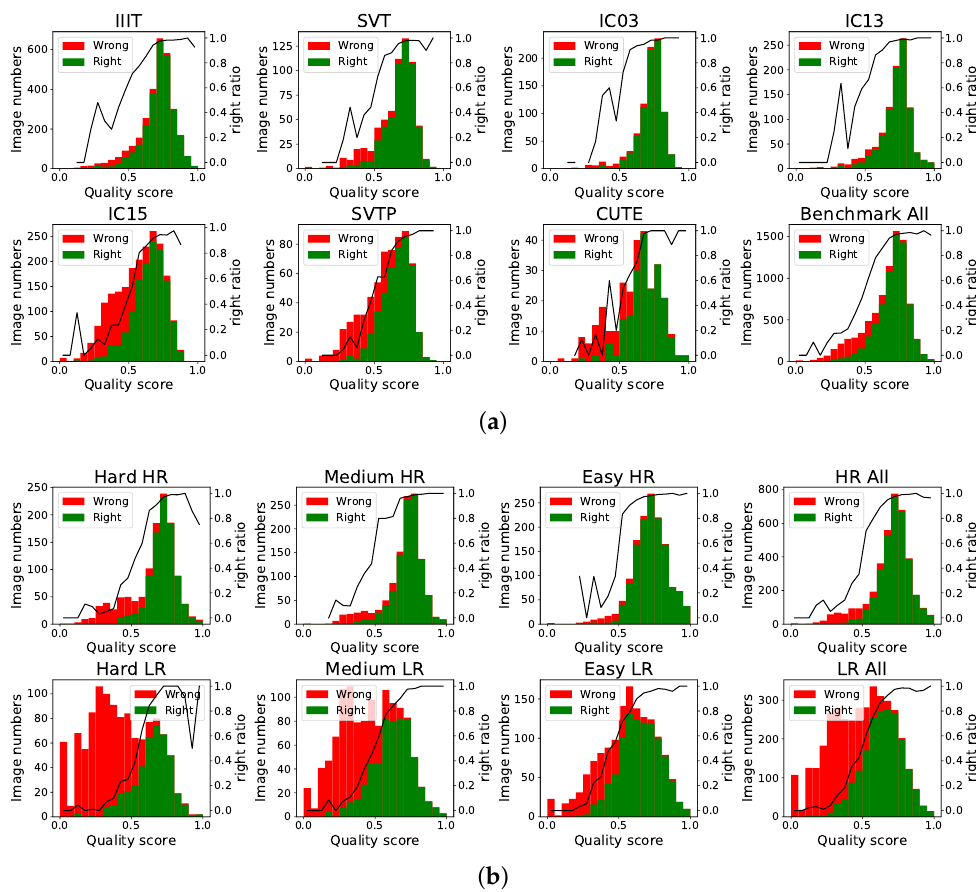
Figure 11. Score distribution map of benchmarks and Textzoom. The last figure in ( a ) shows the overall distribution of the benchmark. The last row in ( b ) shows the overall distribution of the HR and LR dataset. We divide the scores into 20 parts and calculate the proportion of correctly recognized samples shown in black